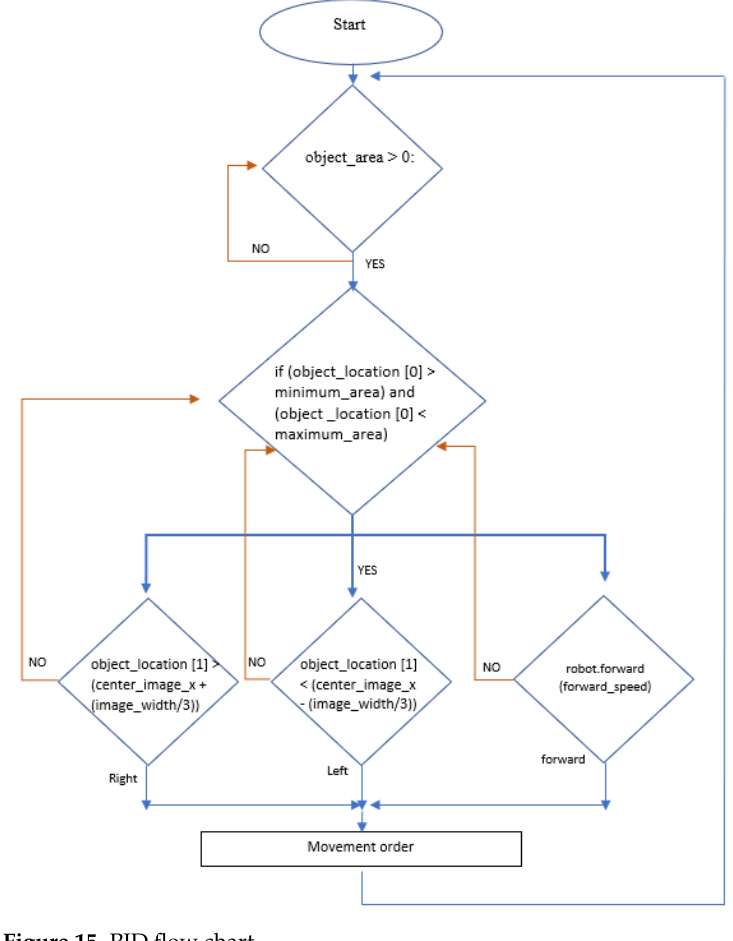
Figure 15. PID flow